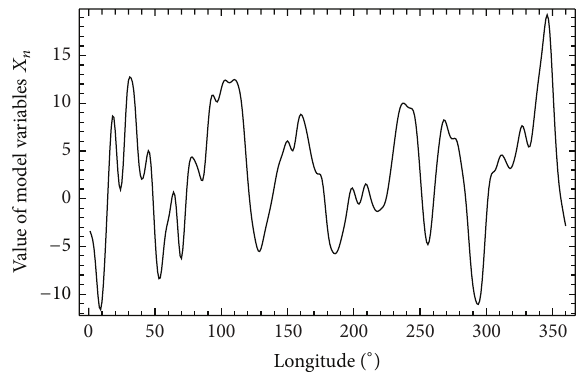
Figure 1: An example of longitudinal structure of model variable 𝑋